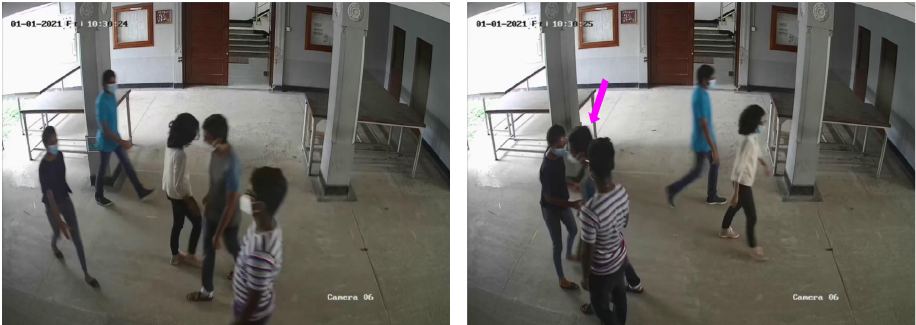
Figure 14. Failure case 1 threat level interpretations. System output for threat—Decreases, Human expert opinion on